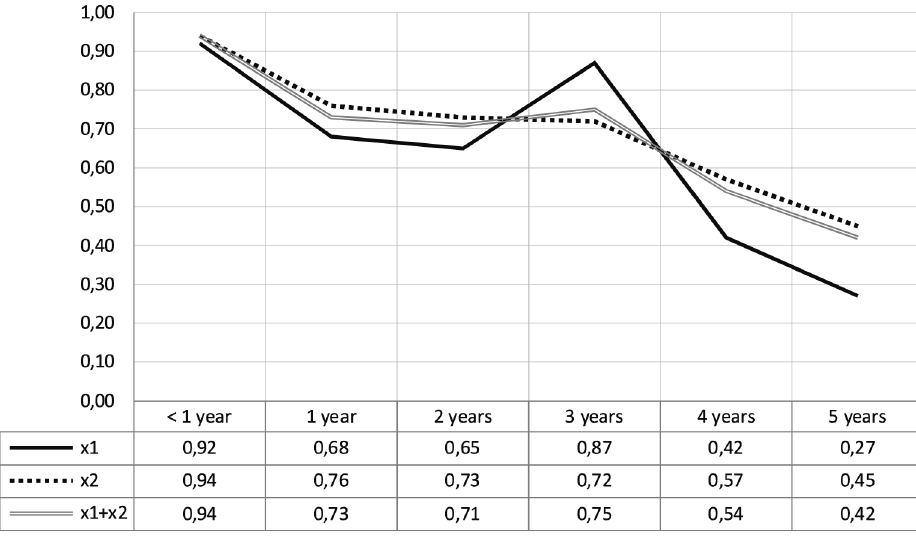
retention indicator in 2018 for the x VIN